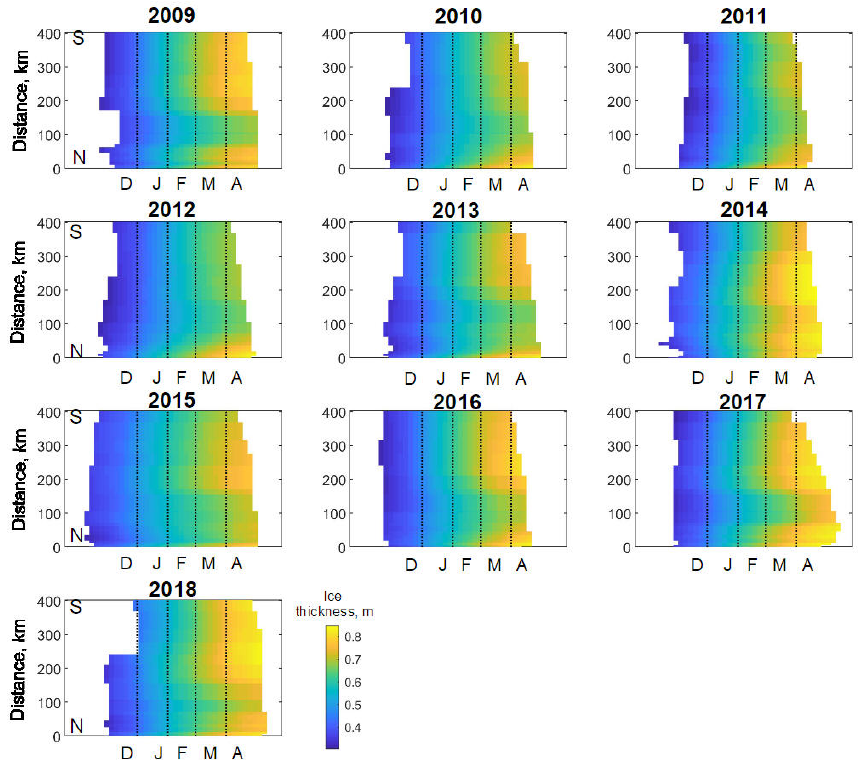
Figure 10. Spatiotemporal ice thickness variability (m) for the main branch of all the lower Ob River reaches for the 2008–2018 period from the generalised weekly altimetric product. Distance (km) is indicated from the northernmost virtual station 187 in the upstream direction (south). Letters on the x axis correspond to the first letter of the month (December–April). Table 3. Correlation coefficient ( R ) and RMSE between the retrieved and in situ ice thickness in the cross-validation experiment. Virtual Corresponding VS whose R RMSE (m) stations gauging coefficients station a and b are used for cross-validation 161 Pitlar 138 0.94 0.09 138 Pitlar 161 0.94 0.09 237 SOb Muzhi 240 SOb 0.90 0.10 240 SOb Muzhi 237 SOb 0.89 0.11 240 Gorki 135 0.81 0.13 135 Gorki 240 0.87 0.11 164 Kazym Mys 211 0.84 0.10 211 Kazym Mys 164 0.76 0.13 12